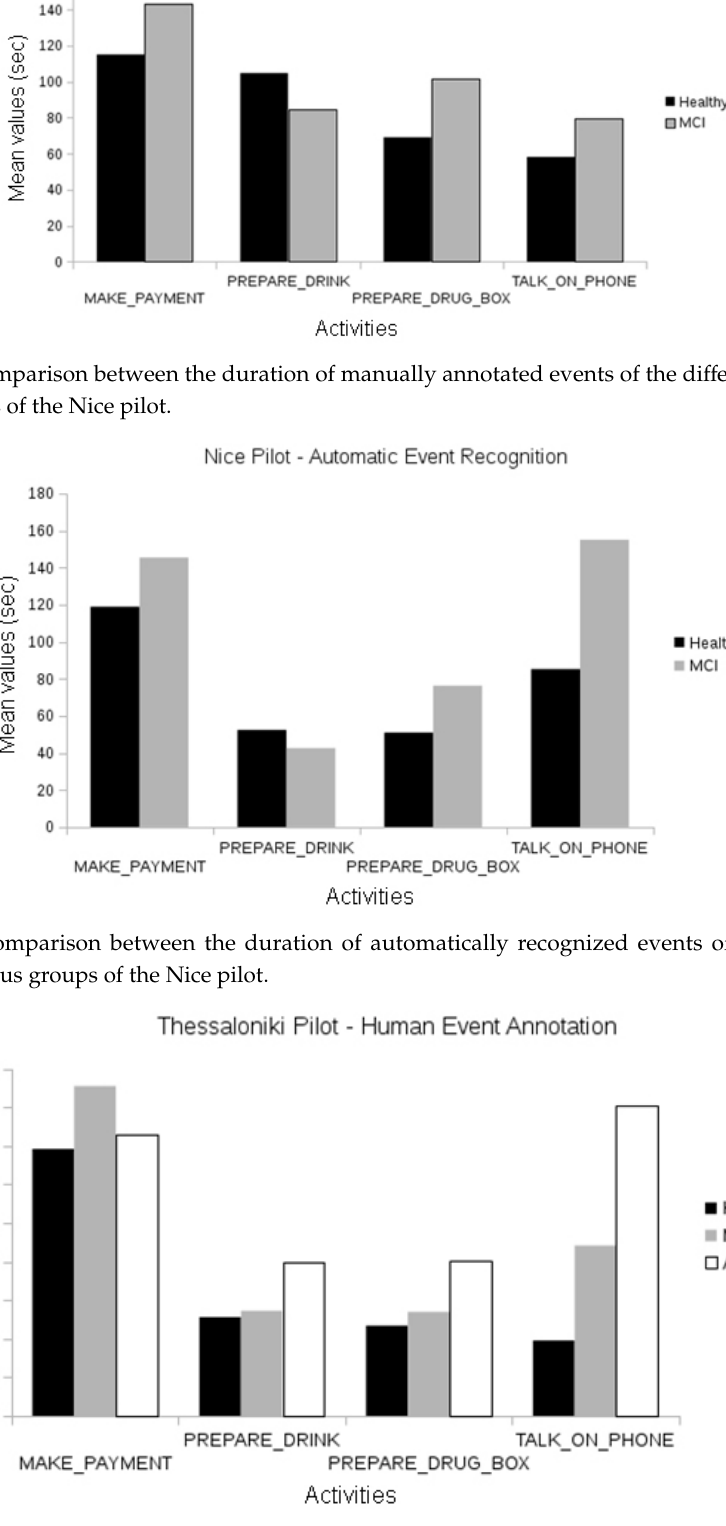
Figure 10. Comparison between the duration of manually annotated events of the di ff erent cognitive status groups of the Thessaloniki pilot.